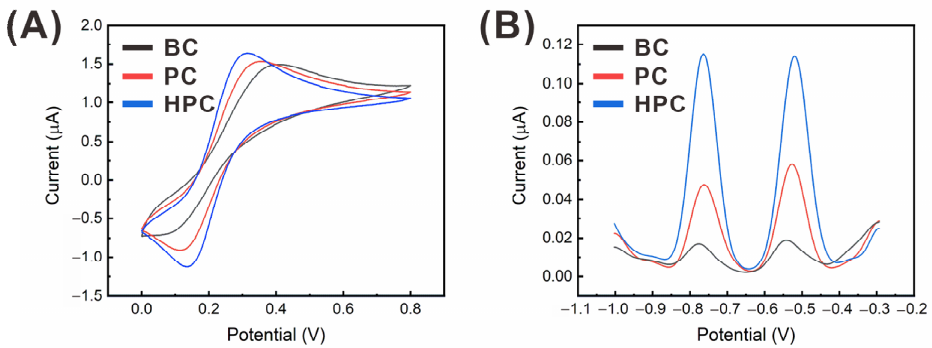
Figure 5. ( A ) Cyclic voltammograms of 10 mM ferrocyanide in 0.5 M KCl at the scan rate of 0.05 V/s.